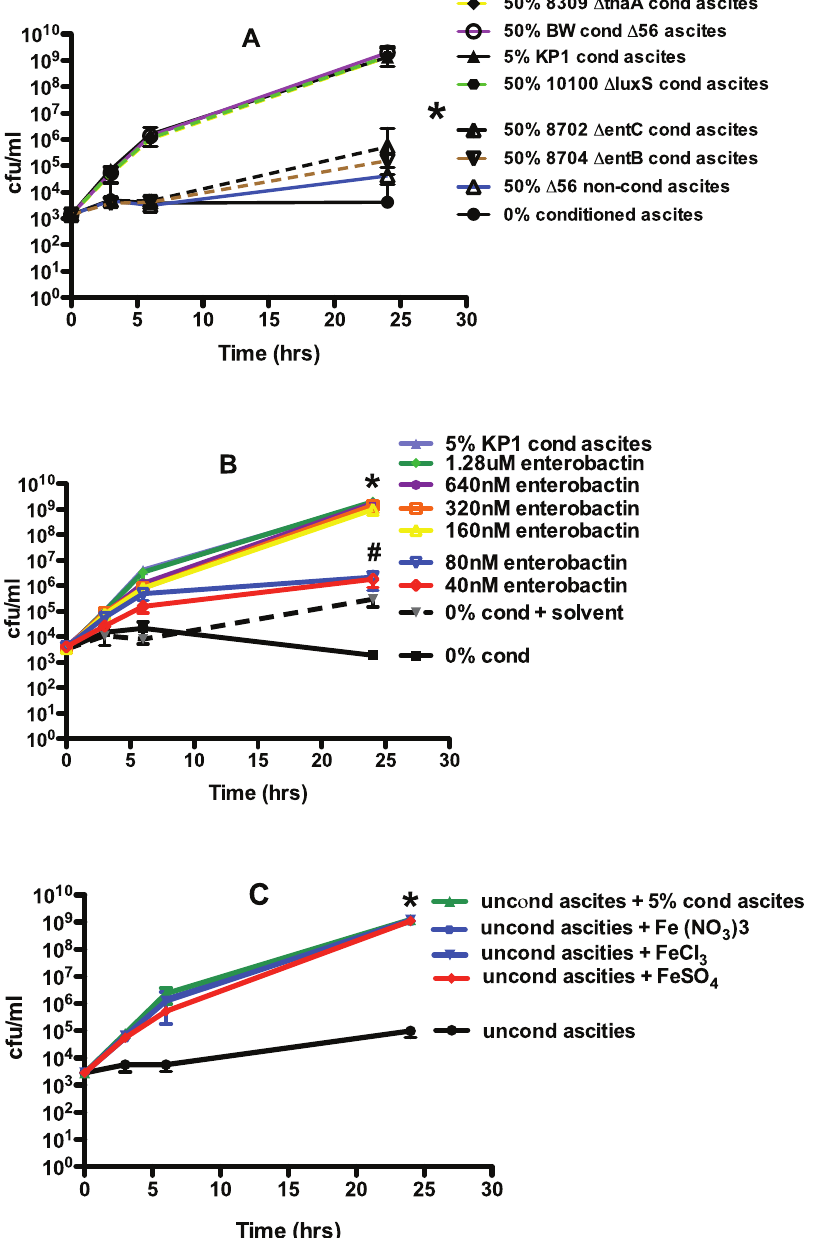
Figure 8. Identification of the class of mediators present in the hvKP1 generated conditioned minimal medium and ascites that enhance the growth and/or survival of hvKP1. The growth of hvKP1 was assessed at 0, 3, 6, and 24 hours in human ascites (batch 1). Panel A: Ascites was not supplemented (unconditioned) or supplemented with: 1) 5% hvKP1-generated conditioned (cond) ascites (batch 1) or 2) 50% conditioned ascites generated from the E. coli laboratory strain BW25113 and isogenic derivatives deficient in the production of enterobactin (BW25113 D entB (CGSC # 8704), BW25113 D entC (CGSC # 8702)), AI-2 molecules (BW25113 D luxS (CGSC # 10100)), and indole (BW25113 D tnaA (CGSC # 8309)) (batch 1). The growth and/or survival of hvKP1 was significantly decreased when grown in ascites supplemented with conditioned ascites generated by the E. coli strains deficient in enterobactin production compared to when grown in ascites supplemented with conditioned ascites generated by the E. coli strains sufficient in enterobactin production or with conditioned ascites generated by hvKP1 (*P , 0.05/4). Data are Mean 6 S.E.M.; N=3. Panel B: Ascites (batch 1) was not supplemented (unconditioned) or supplemented with: 1) solvent alone (0.86% DMSO), 2) 5% hvKP1-generated conditioned (cond) ascites (batch 1), or 3) 40nM, 80nM, 160nM, 320nM, 640nM, and 1.28 m M of purified enterobactin. The growth and/or survival of hvKP1 was significantly increased when grown in ascites supplemented with 160nM, 320nM, 640nM, and 1.28 m M of purified enterobactin (*P , 0.05/6) and there was a trend for an increase with supplementation with 40nM and 80nM of purified enterobactin ( # P . 0.05/6 and , 0.1) compared to growth and/or survival of hvKP1 grown ascites plus solvent alone. Data are Mean 6 S.E.M.; N=3–4. Panel C: Ascites (batch 2) was not supplemented (unconditioned) or supplemented with 0.1mM of Fe (NO 3 )3, FeCl 3 , or FeSO 4 , and 5% hvKP1 generated conditioned ascites. The growth and/or survival of hvKP1 was significantly increased when grown in ascites supplemented with iron-containing compounds (*P , 0.05/3). Data are Mean 6 S.E.M.; N=2.